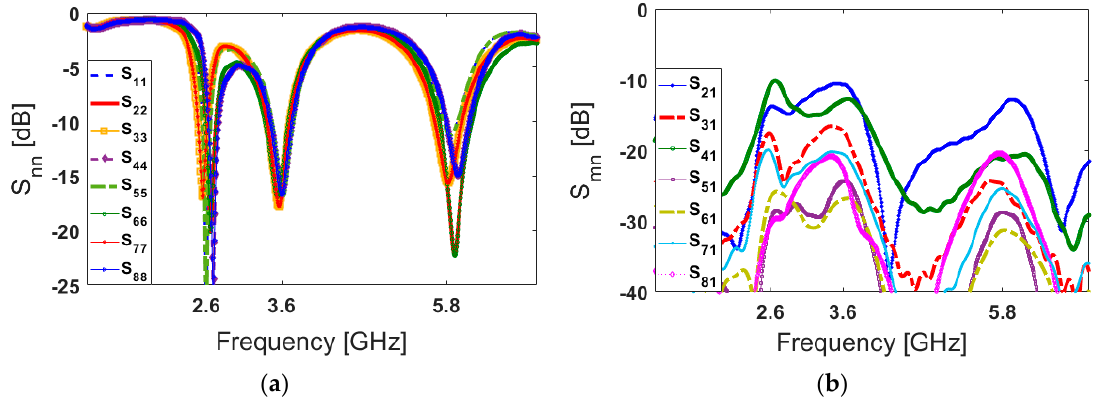
Figure 6. ( a ) S nn and ( b ) S mn properties of the proposed 5G handset antenna.